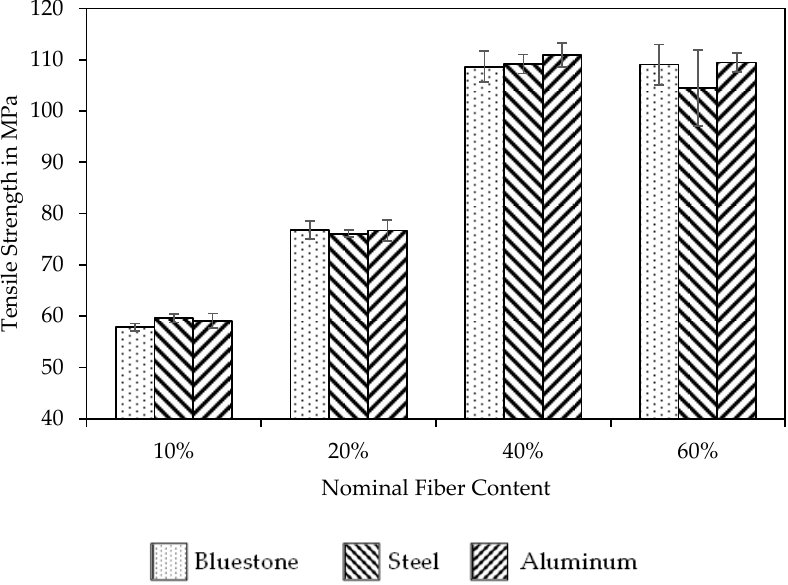
Figure 15. Tensile strength for tensile specimens from Bluestone, steel, and aluminum tools for nominal fiber contents of 10 wt.%, 20 wt.%, 40 wt.%, and 60 wt.%.